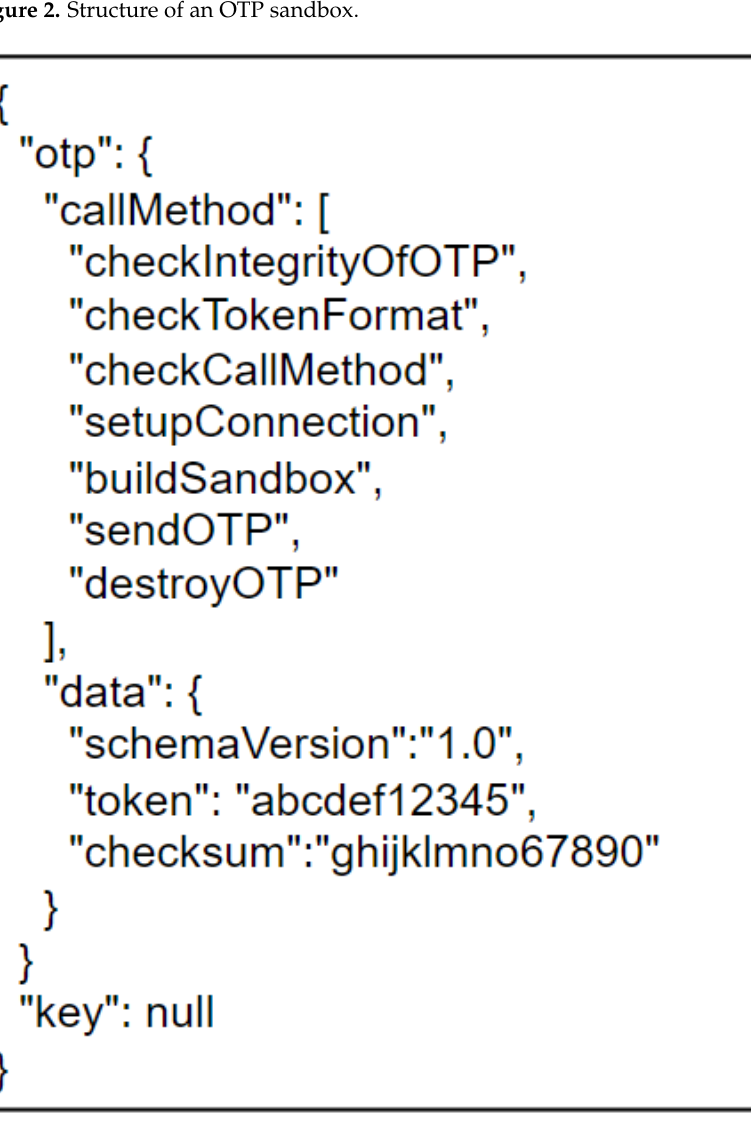
Figure 3. Clear version of the